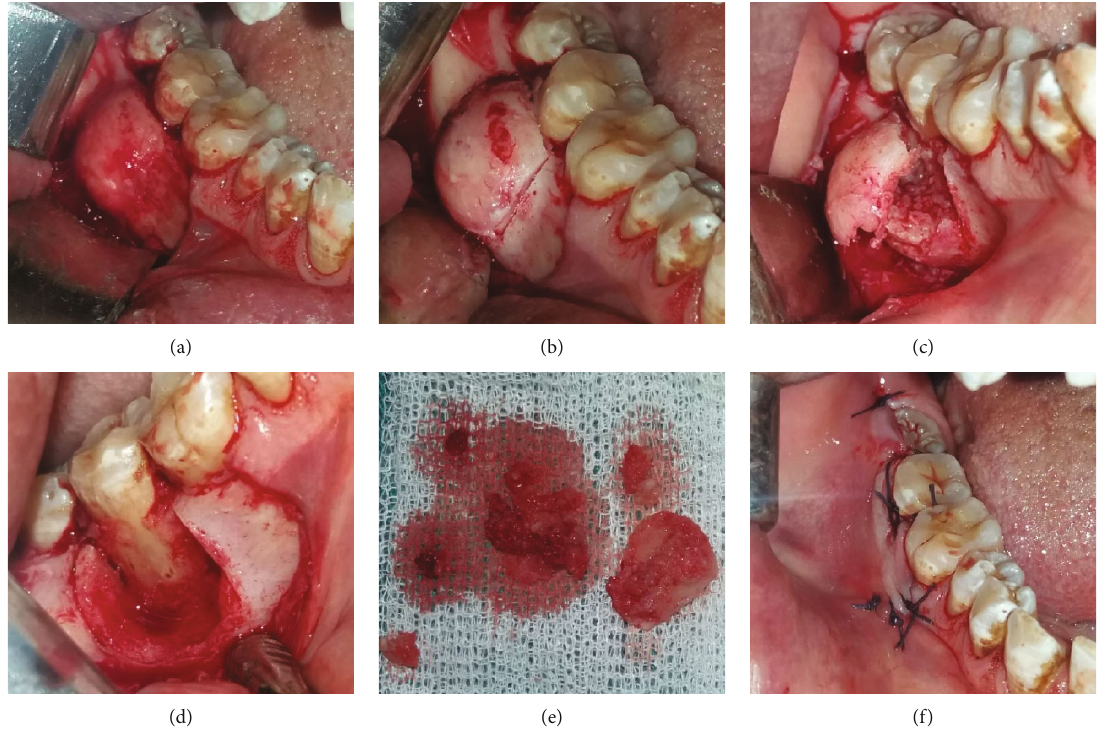
Figure 4: (a) Surgical access to the vestibular mandibular region showing bone deformation. (b) Minimal operative and atraumatic vertical osteotomy was performed by piezosurgery. (c) Intraoperative photograph following tumor exposure. (d) Surgical enucleation with curettage of the lesion; note the large defect and the exposition of the roots of the 47. (e) Surgical piece. (f) Flap repositioning and